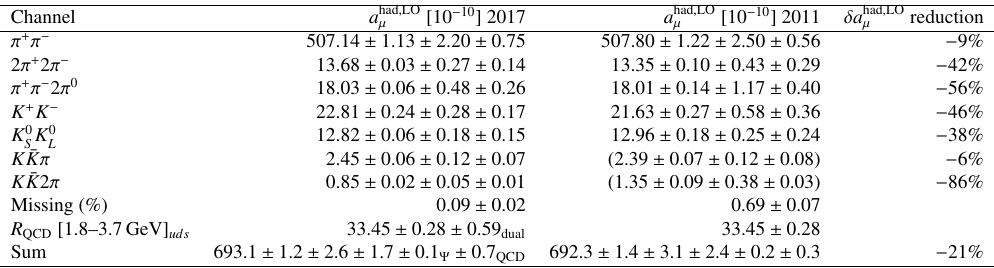
Table 1. Comparison of the new evaluation with our previous one and their relative uncertainty reduction. Where three (or more) uncertainties are given, the first is statistical, the second channel-specific systematic, and the third common systematic, which is correlated with at least one another channel. For the contribution computed from QCD, only the total uncertainties are given, which include e ff ects from the α s uncertainty, the truncation of the perturbative series at four loops, the FOPT vs. CIPT ambiguity, and quark mass uncertainties. The additional uncertainty dubbed “dual” estimates possible quark-hadron duality violating e ff ects in the QCD estimate between 1.8 and